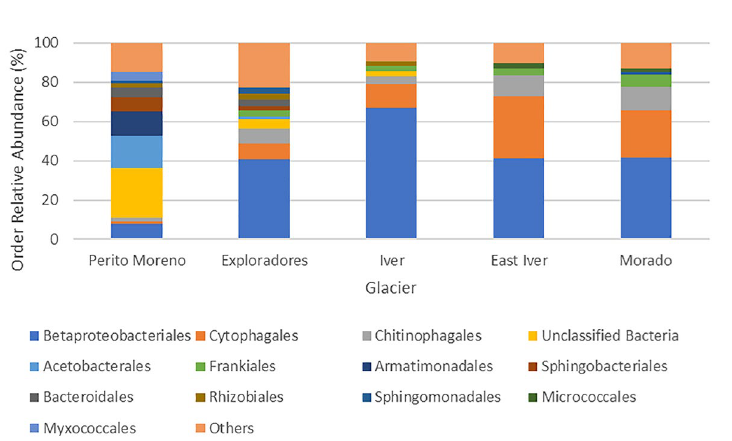
Figure 2. Boxplots of pH ( a ) and oxygen concentration ( b ) of cryoconite holes in the investigated South American glaciers. The thick lines represent the median, boxes upper and lower limits the 25th and the 75th percentiles respectively, whiskers the 5th and the 95th percentiles respectively, dots represent the outliers and different letters indicate significant differences between glaciers at post-hoc tests.